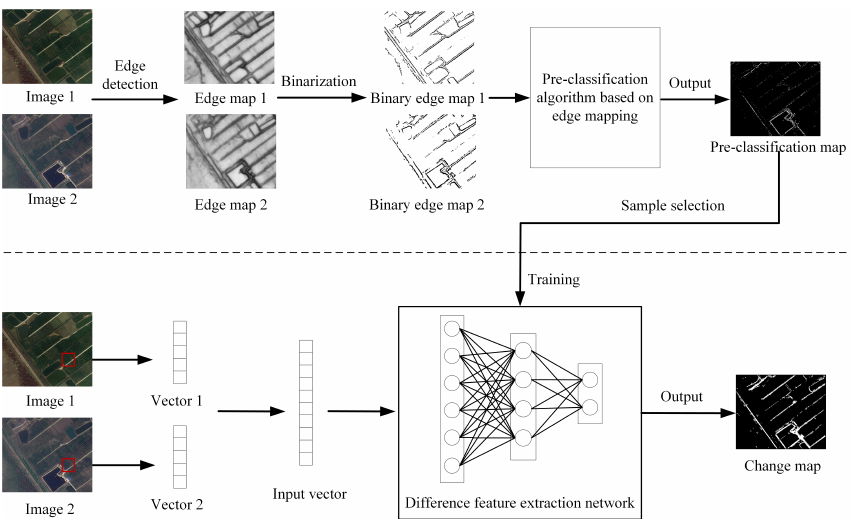
Figure 1. The framework of the proposed change detection